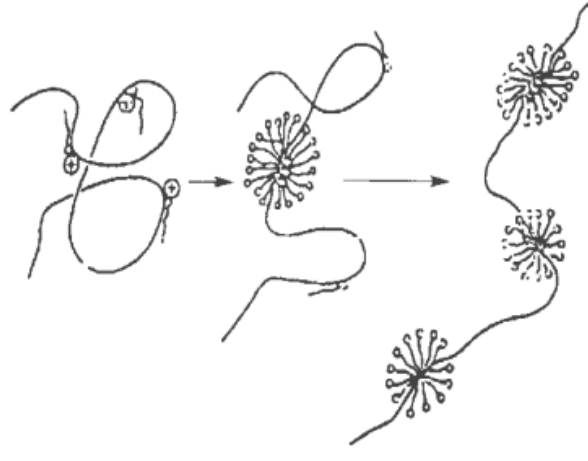
Figure 6. Bead model of the surfactant–polymer mixture [41].